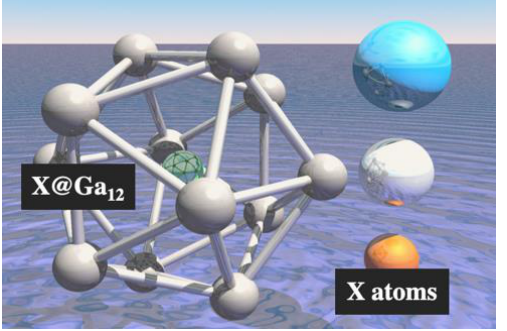
Figure 4. Cluster models X@Ga 12 (X = Li~Kr) substituted for a central atom in the icosahedral Ga 12 cage. The changes in energy levels and the effects of the two parameters were